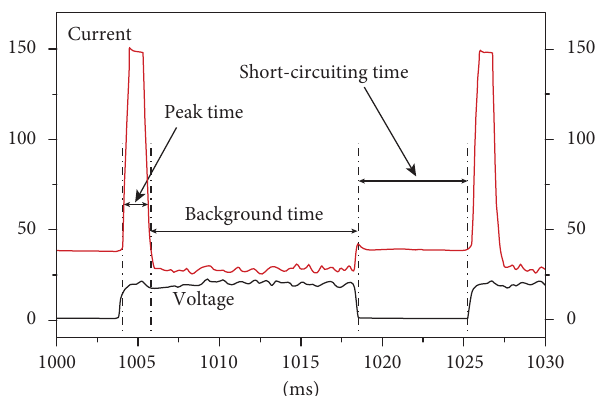
Figure 2: Waveform of current and voltage in CMT welding